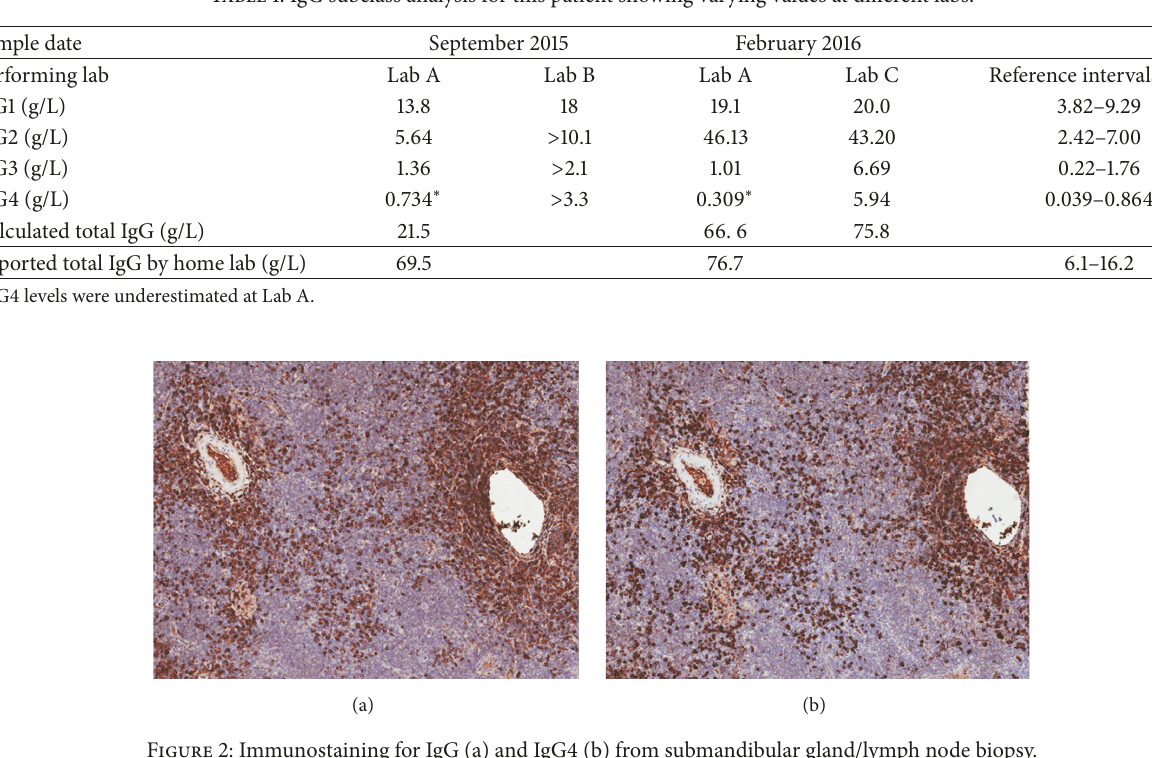
Table 1: IgG subclass analysis for this patient showing varying values at different labs.